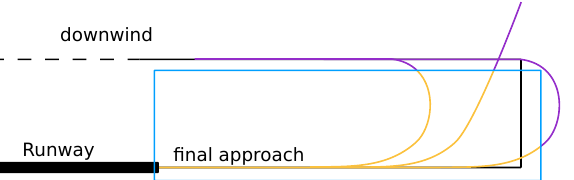
Figure 3. Area of interest, blue rectangle depicts the region to which flight tracks are truncated. The orange part of the flight tracks are part of the data set, the purple parts are discarded. (not to scale).